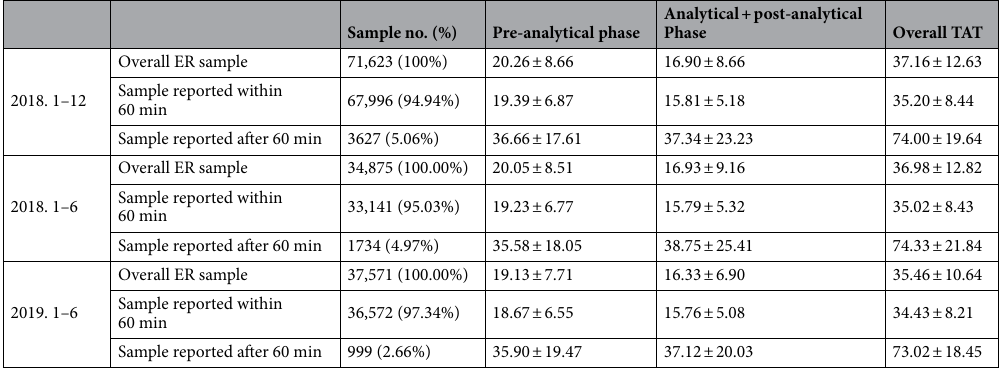
Table 1. Overall statistics of samples: mean and standard deviation (mean ± std) of each phase and overall TAT of clinical chemistry tests at ER, within 60 min and after 60 min.